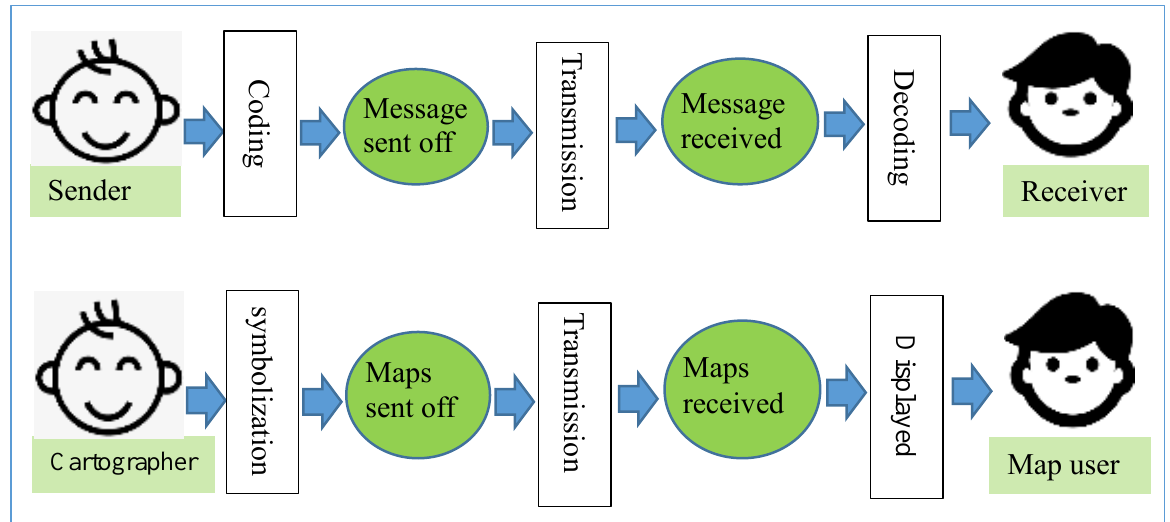
Fig. 6 The flow of information transmission in Cartographic Information